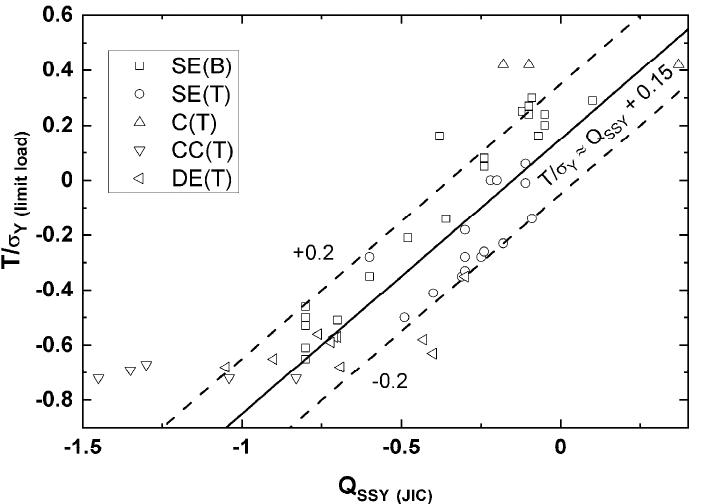
Figure 5. Relation between elastic T-stress at limit load (T/ σ Y ) and elastic–plastic Q parameter at J Ic [5].